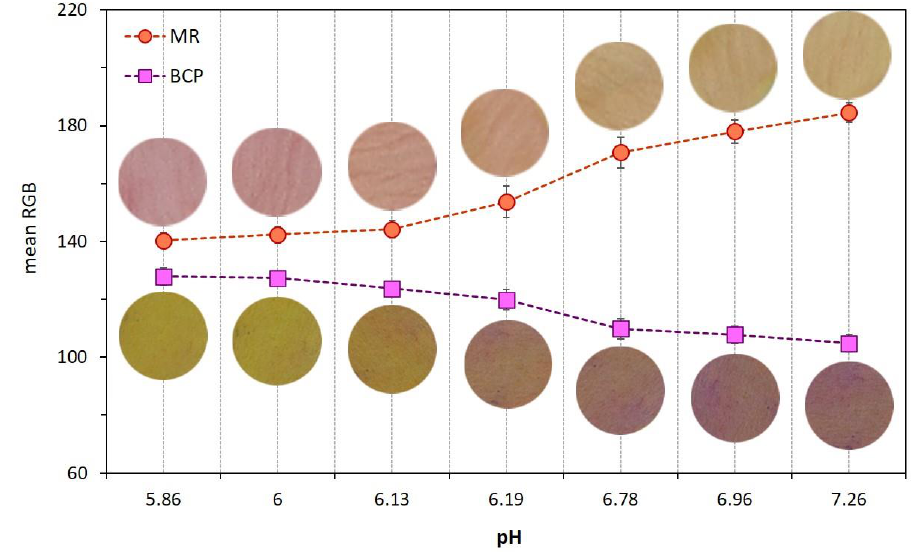
Figure 4. Effect of pH variation of uncoated chicken meat on dual-sensors label visual color and their mean RGB values.